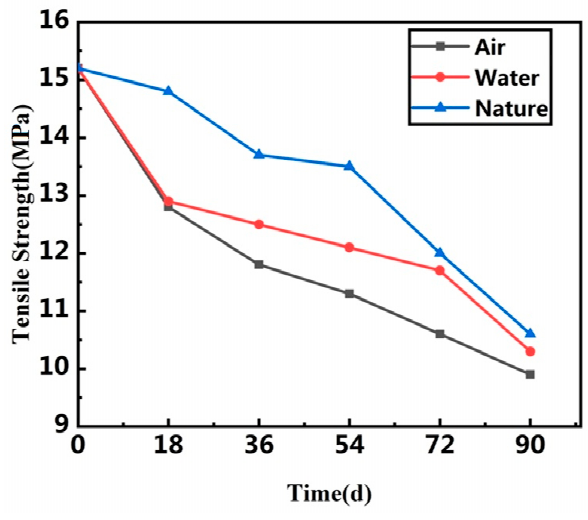
Figure 5. Tensile strength of waterstop in three different environments.